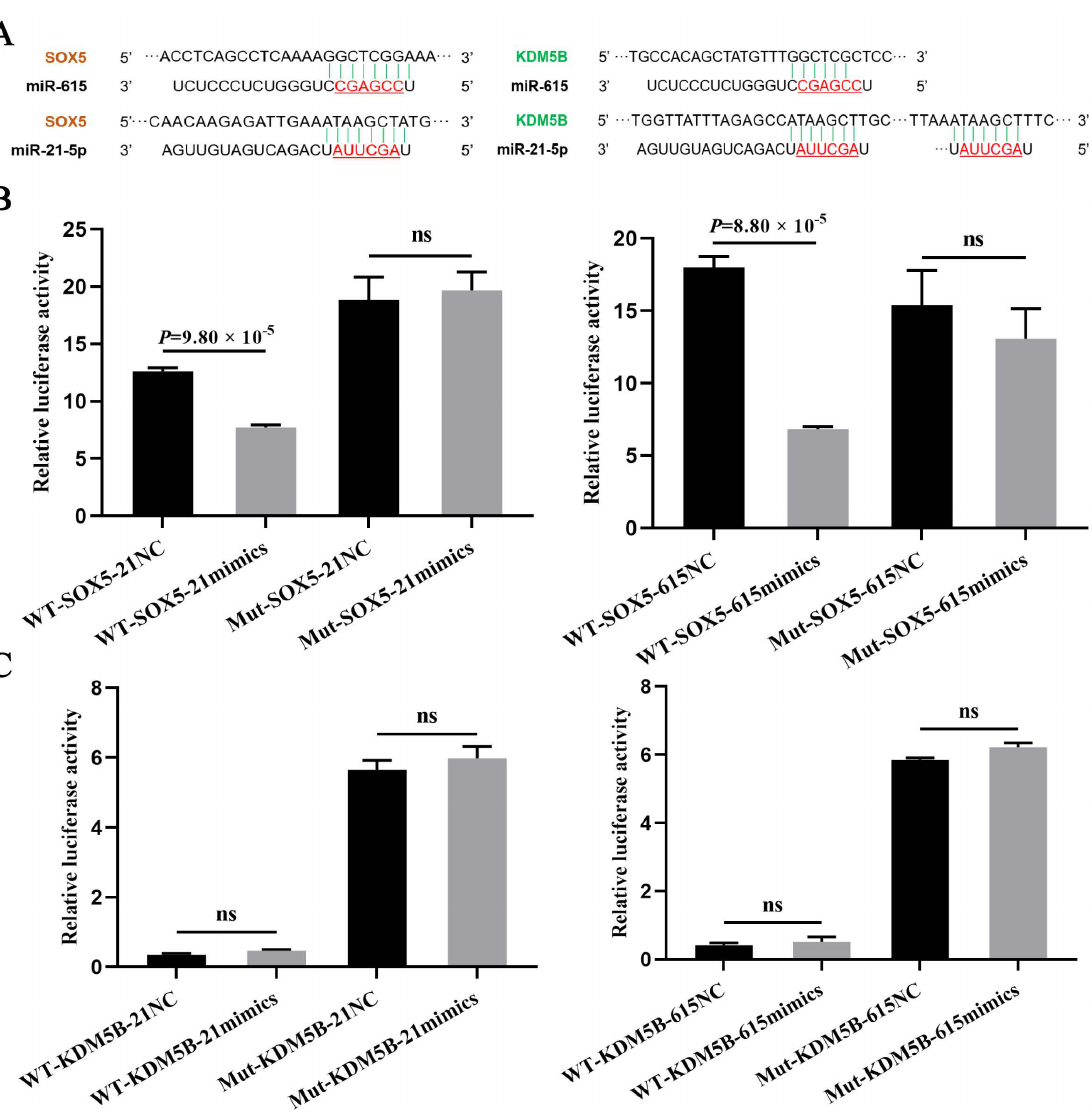
Figure 4. miR-21-5p and miR-615 can both target to SOX5 gene. ( A ) The schematic diagram of binding sites within miRNA and 3 (cid:48) UTR of target genes (Red underlined means the seed region of miRNA). ( B , C ) The target relationship verification of two potential target genes (SOX5 and KDM5B) with miR- 21-5p and miR-615, respectively, by Dual-Luciferase reporter assay. ns means no significant